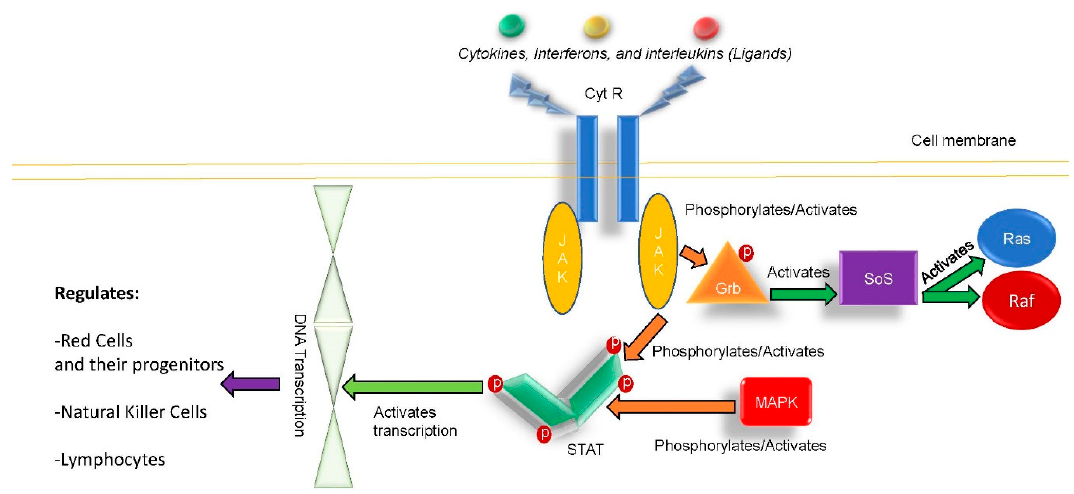
Figure 1. Schematic of Janus kinase 2 pathway (JAK / STAT pathway). CytR, cytokine receptor; DNA, deoxyribonucleic acid; Grb, Growth factor receptor-bound protein 2; JAK-Janus Kinase 1, 2; MAPK, a mitogen-activated protein kinase; P, phosphorous; Ras, rat sarcoma protein; Raf, serine / threonine kinase / cellular homolog of viral RAF gene; SoS, son of sevenless; STAT, signal transducer and activator of transcription.